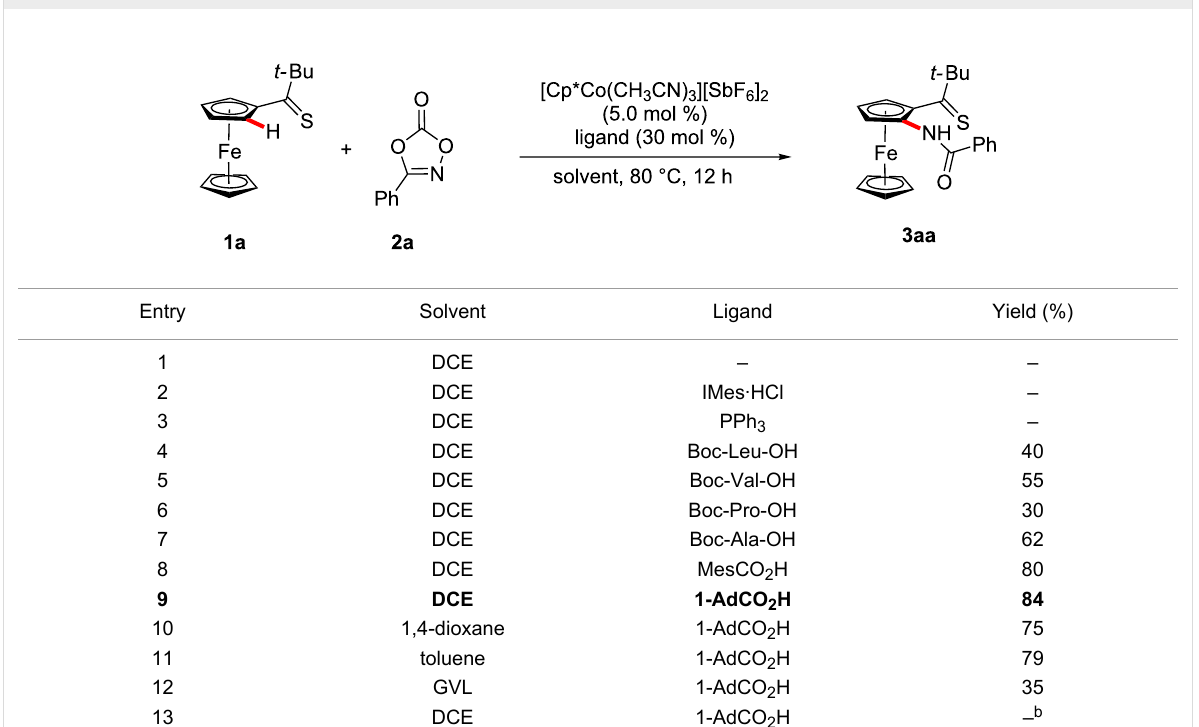
Table 1: Thiocarbonyl-assisted C − H nitrogenation of ferrocene 1a .